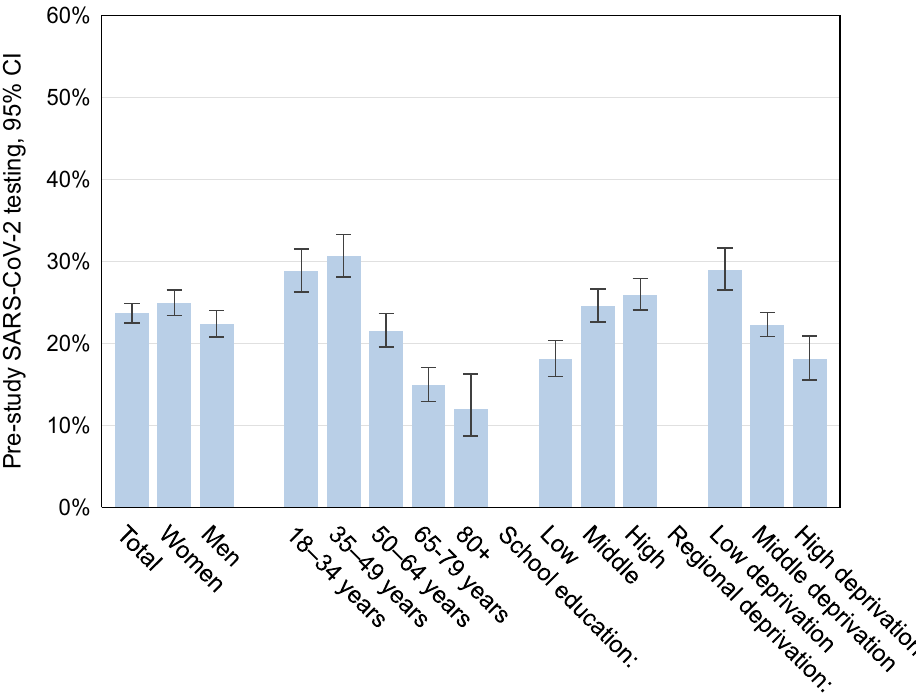
Figure 3. Self-reported SARS-CoV-2 testing since the beginning of the pandemic (14,917 RKI-SOEP study participants with valid and complete self-reports on pre-study tests, participation predominantly in October– November 2020), stratified by sex, age group, school education and regional socioeconomic deprivation (at the district level).